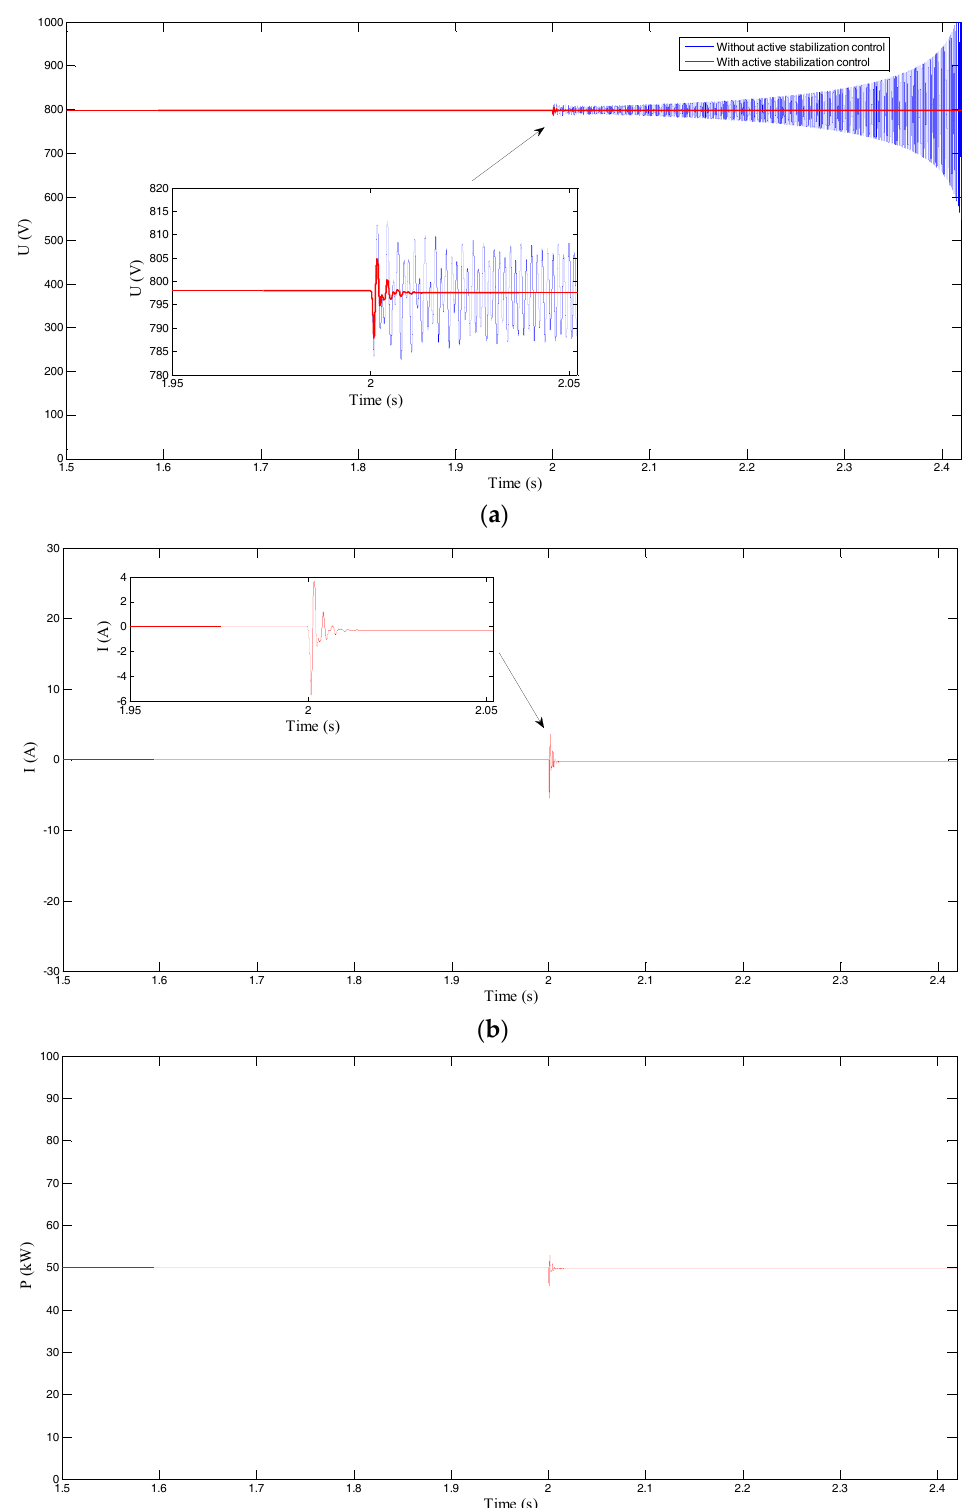
Figure 9. Simulation waveform by changing P s1 = 50 kW to P s1 = 90 kW at t = 2 s: ( a ) U s1 ; ( b ) i s1,active ; and ( c ) P s1 .